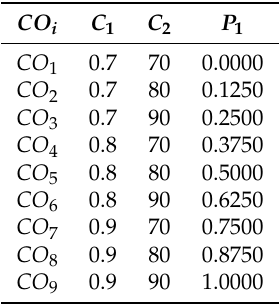
Figure 6. Visualization of triangular fuzzy numbers for Effectiveness per round assessment model ( P 1 ). Table 3. Overview of characteristic objects CO , vector P values for the Effectiveness per round assessment